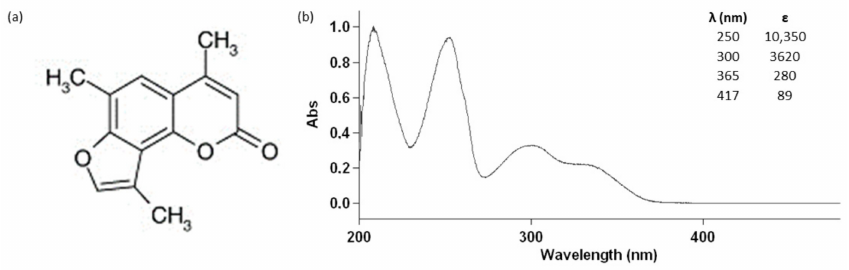
Figure 1. Chemical structure ( a ) and absorption spectrum ( b ) of 4,6,4 (cid:48) -trimethylangelicin (TMA) and its molar extinction coefficients at 250 nm, 300 nm, 365 nm, and 417